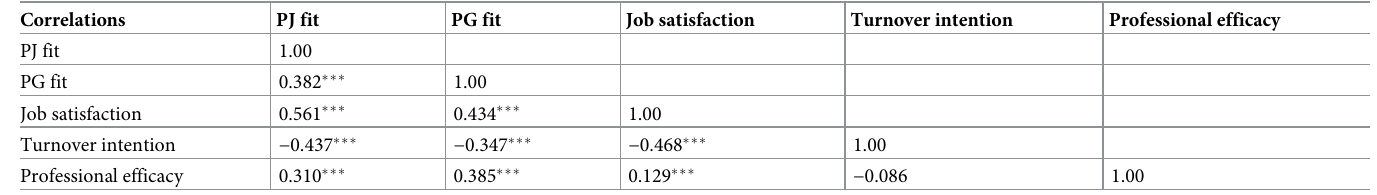
Table 3. Correlations of indicators for Shanghai medical workers in